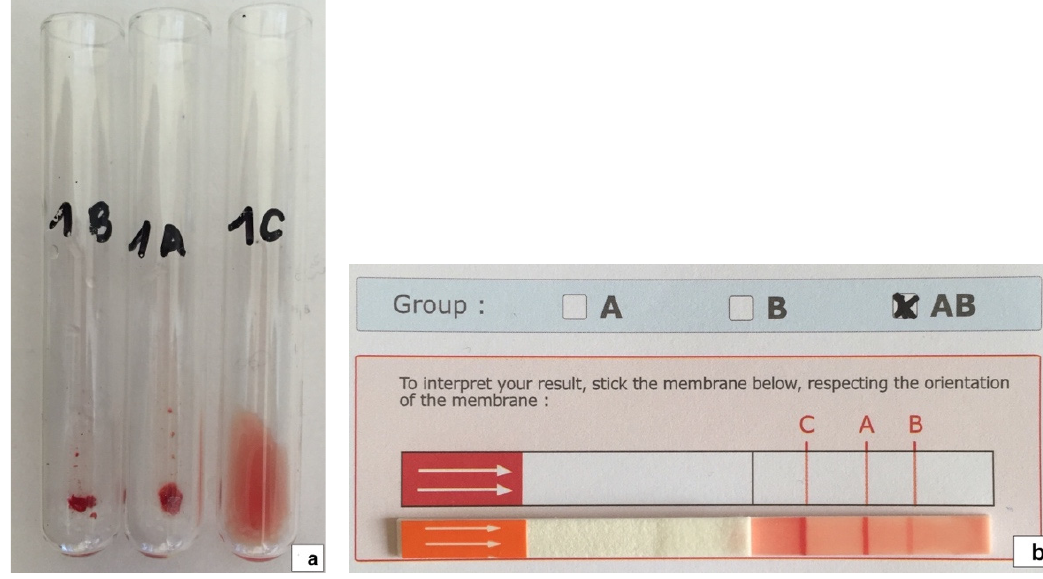
Figure 1. ( a ). Feline blood sample shown to be phenotype AB using the agglutination on